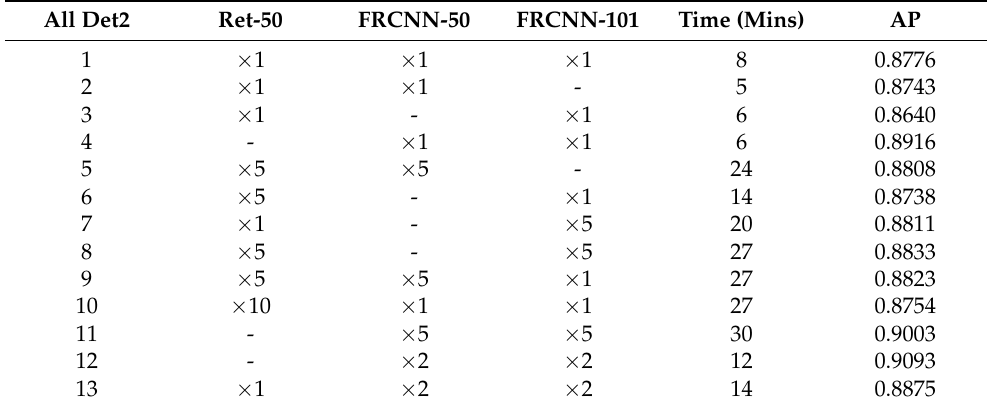
Table A4. Composition and AP values of ensembles comprising only Detctron2 API detectors.